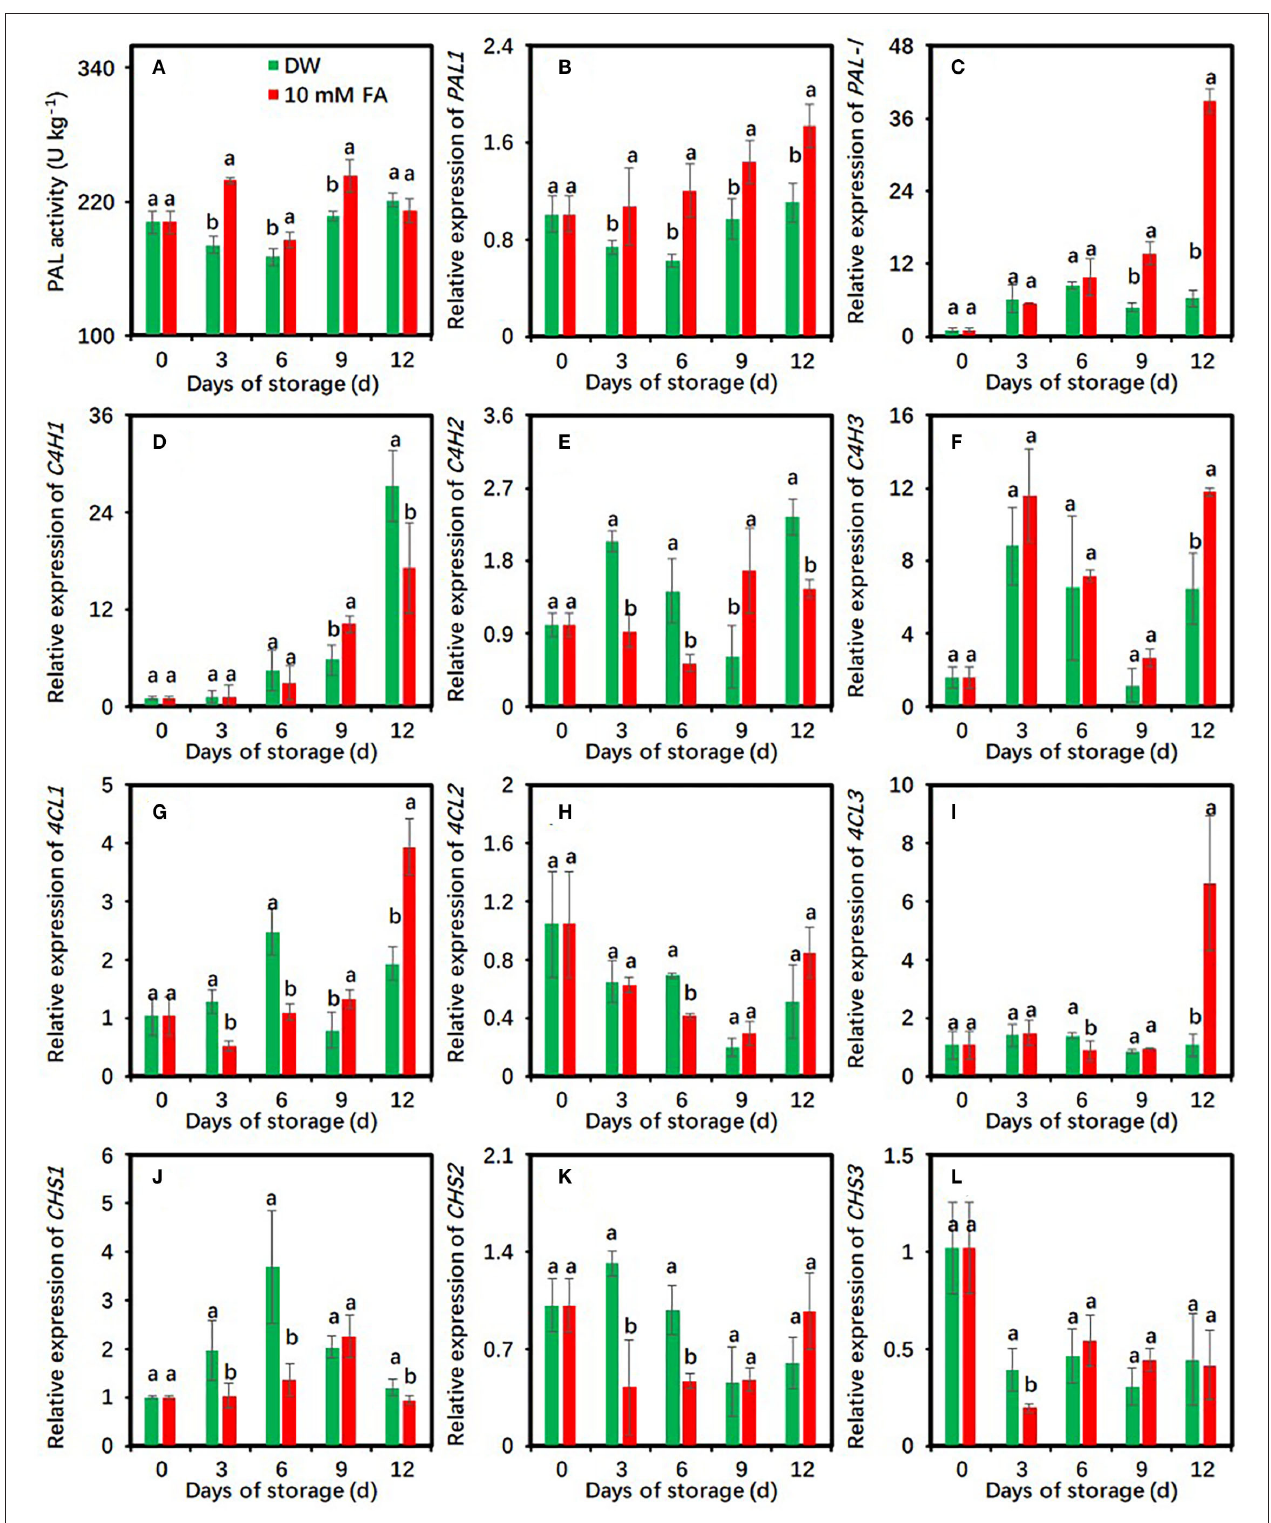
FIGURE 3 | Effects of 10mM FA treatment on the activity and gene expression of enzymes in the phenylpropanoid pathway in taro slices during storage at 5 ◦ C. (A–C) PAL activity and two PAL gene expression; (D–F) three C4H gene expression; (G–I) three 4CL gene expression; (J–L) three CHS gene expression. Each value is presented as means ± standard deviation (SD, n = 3). Statistical differences ( p ≤ 0.05) between the control and 10 mM FA treatment at the same time point are analyzed and indicated using different letters above the bars.